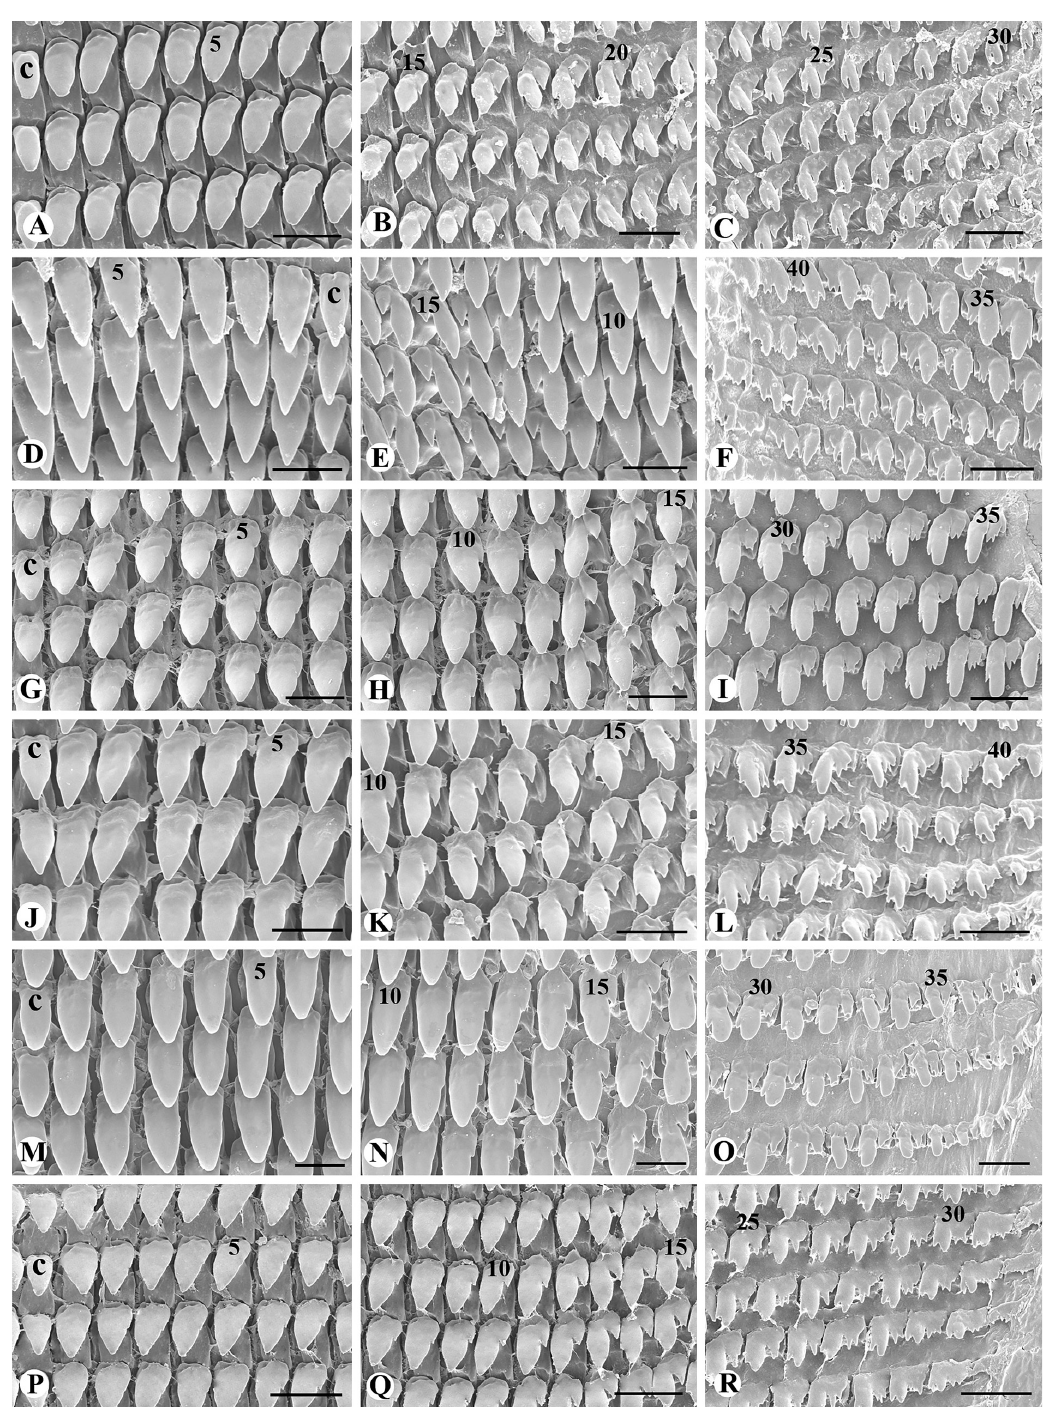
Fig. 6. Radula morphology of Landouria spp. from northeastern Thailand. A–C , G–R . Right side of central teeth. D–F . Left side of central teeth. A–C . Landouria circinata sp. nov., paratype (NHMSU-00024). D–F . L. tuberculata sp. nov., paratype (NHMSU-00026). G–I . L. trochomorphoides sp. nov., paratype (NHMSU-00028). J–L . L. chloritoides sp. nov., paratype (NHMSU-00030). M–O . L. elegans sp. nov., paratype (NHMSU-00033). P–R . L. diplogramma (Möllendorff, 1902) comb. nov. (NHMSU-00034) . Numbers indicate order of lateral and marginal teeth. Abbreviation: c = central tooth. Scale bars = 25